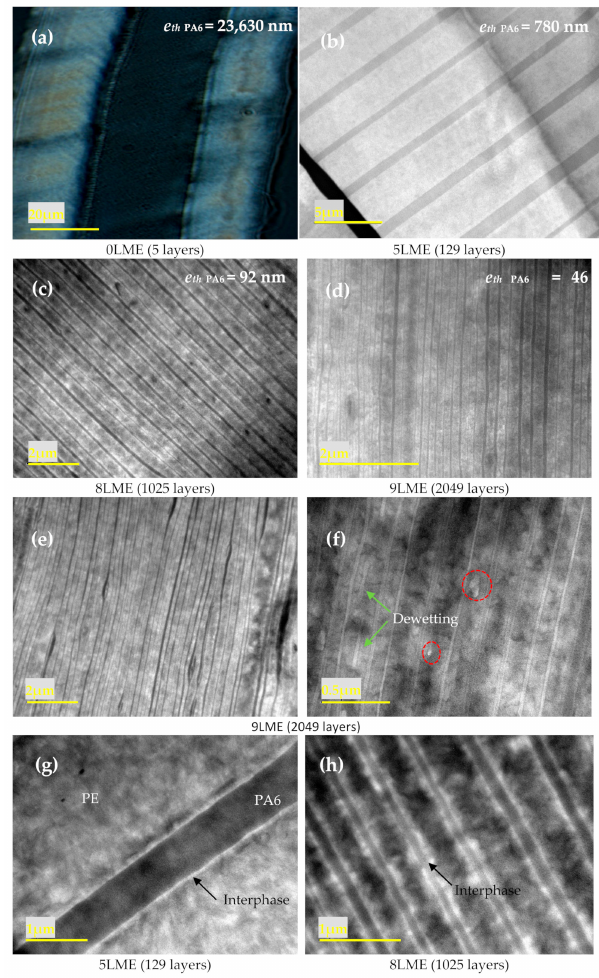
Figure 2. Optical ( a ), TEM ( b – f ), images of ( a – f ) PE/PEgMA/PA6 multilayer films using 0 ( a ), 5 ( b , g ), 8 ( c , h ) and 9 ( d – f ) multiplying